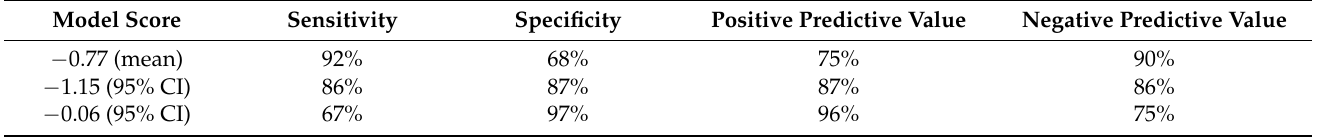
Table 7. Performance of the multivariate regression model for predicting presence of ARC. Model